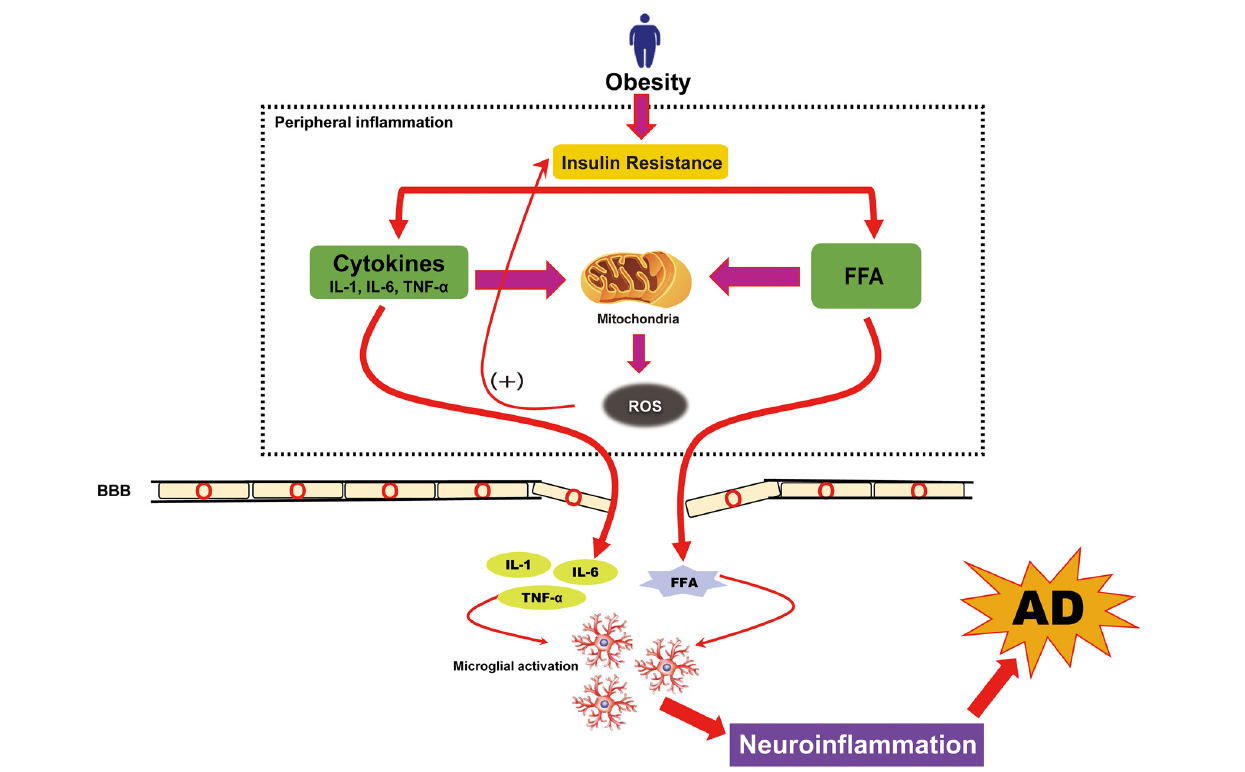
FIGURE 3 | Obesity-induced neuroinflammation in AD. Neuroinflammation caused by obesity is known to arise from low-grade, chronic peripheral inflammation. Obesity-induced insulin resistance causes an overload of free fatty acids (FFAs) and triggers the activation of peripheral cytokines that further increased reactive oxidative stress (ROS). Although peripheral cytokines and FFAs can cross the blood-brain barrier (BBB), their overload causes damage to the BBB. The presence of increased FFAs and cytokines in the brain follows the cytokine production in brain cells (microglia) and causes neuroinflammation. This neuroinflammation is also a pathologic hallmark of